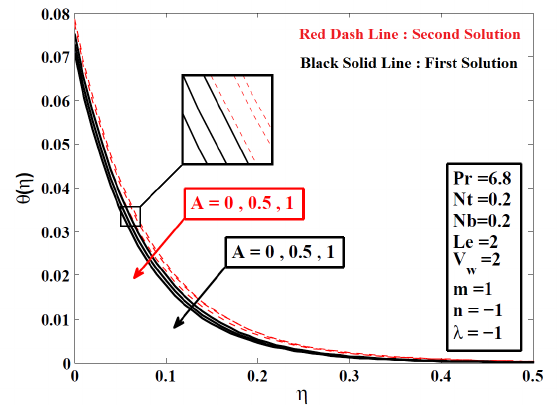
Figure 13: First and second solutions of concentration profile ϕ ( η ) for different values of transpiration rate parameter V w .